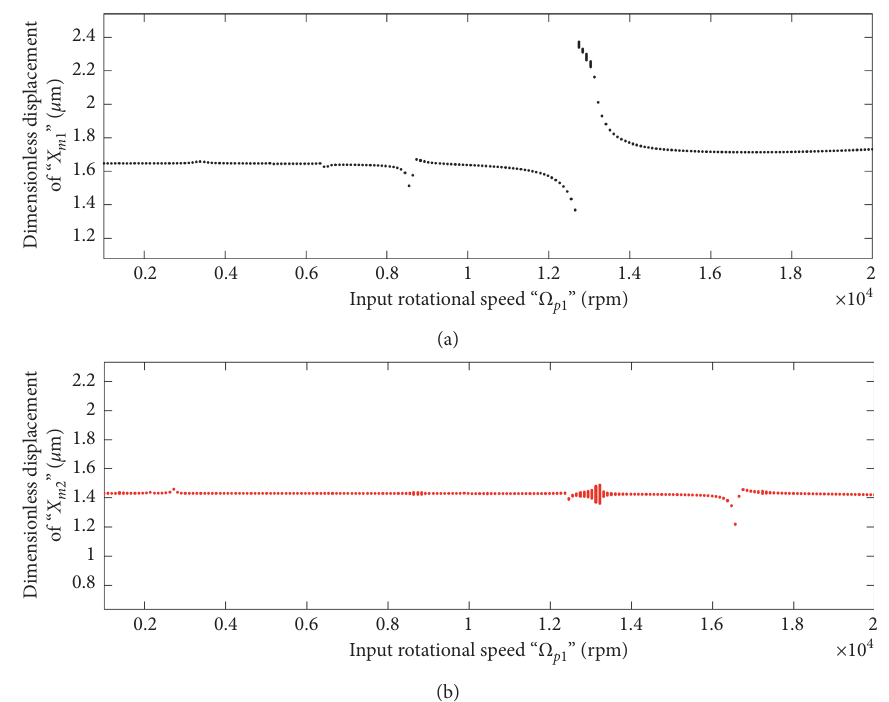
Figure 22: Forward bifurcation diagrams of system when K